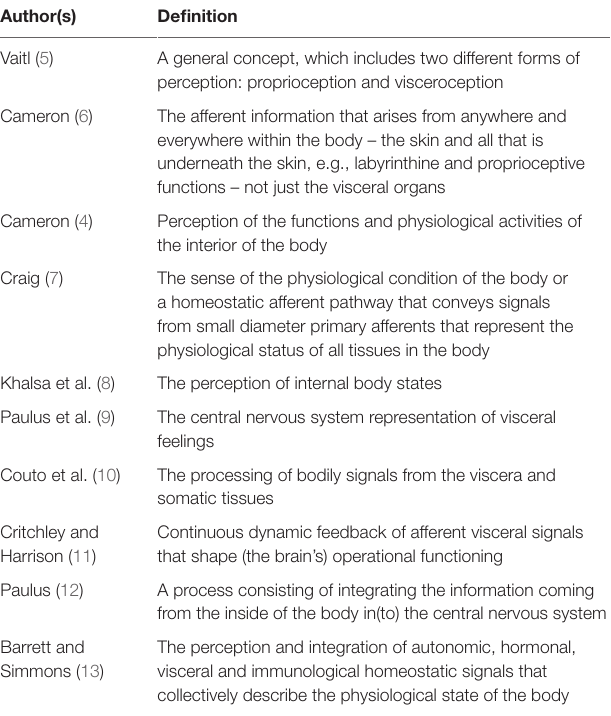
TABLe 1 | Different definitions of